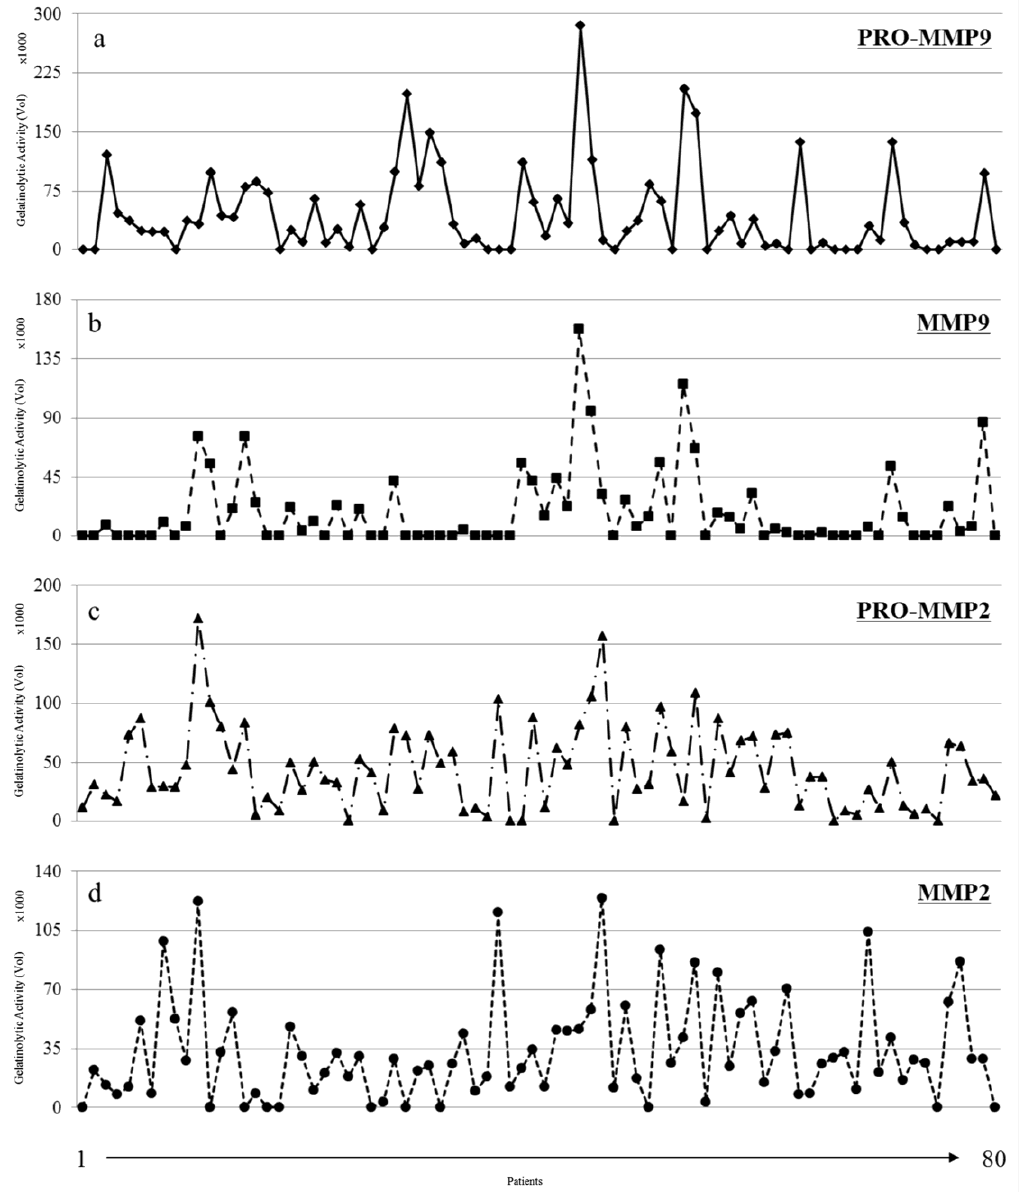
Figure 4. Densitometric profiles of the gelatinolytic bands identified as pro-MMP-9 ( a ), MMP-9 ( b ), pro-MMP-2 ( c ), MMP-2 ( d ) in the 80 breast cancer tissues.